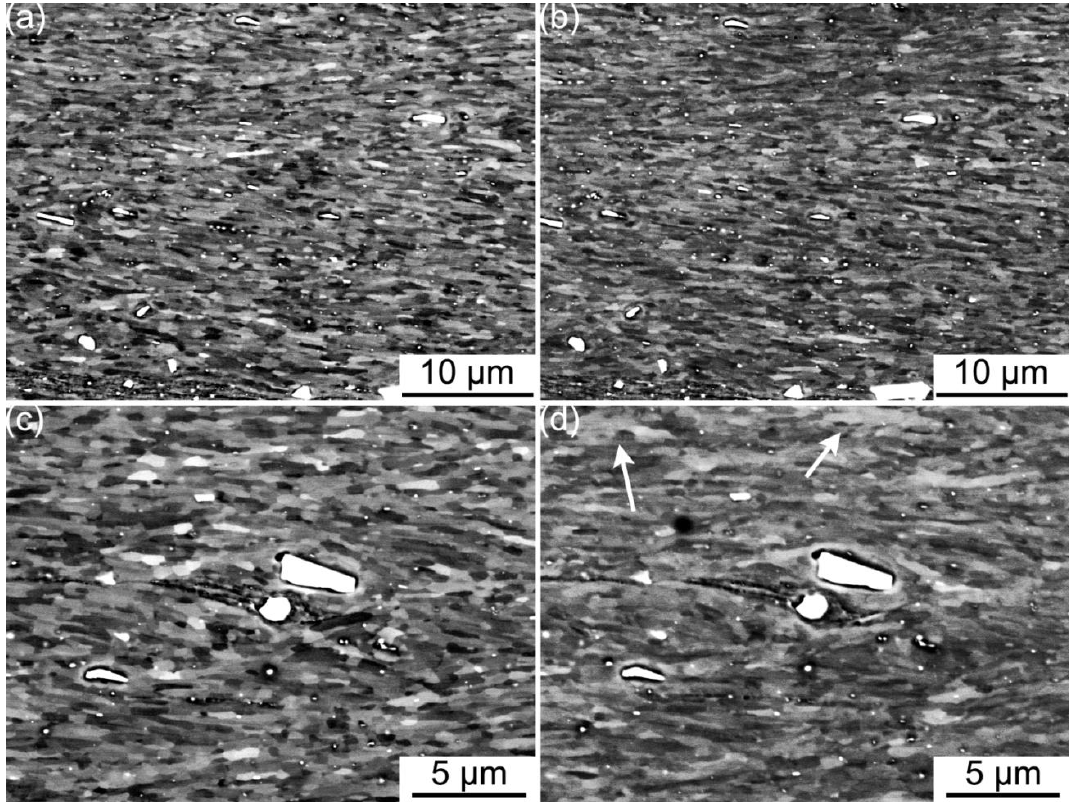
/2 = 3.7 × 10 −3 , ( a ) prior total